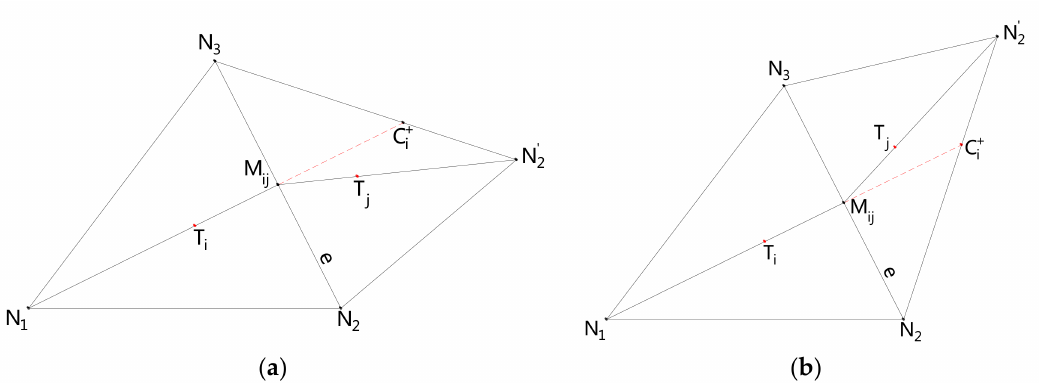
Figure 5. Sketch of the new scheme on triangular grids: ( a ) case (a); ( b ) case